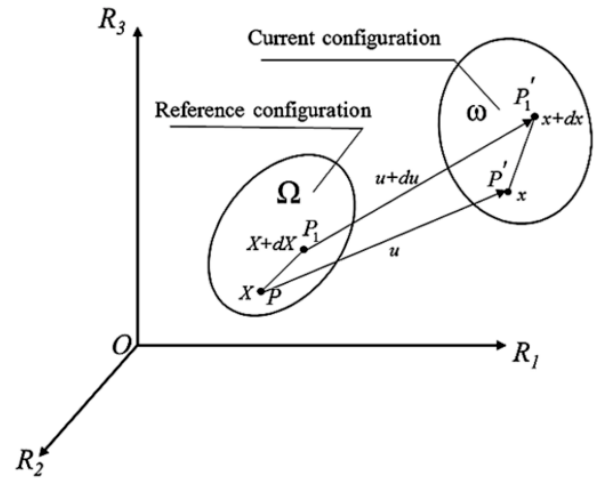
Figure 1. Configurations in deforming the element process.